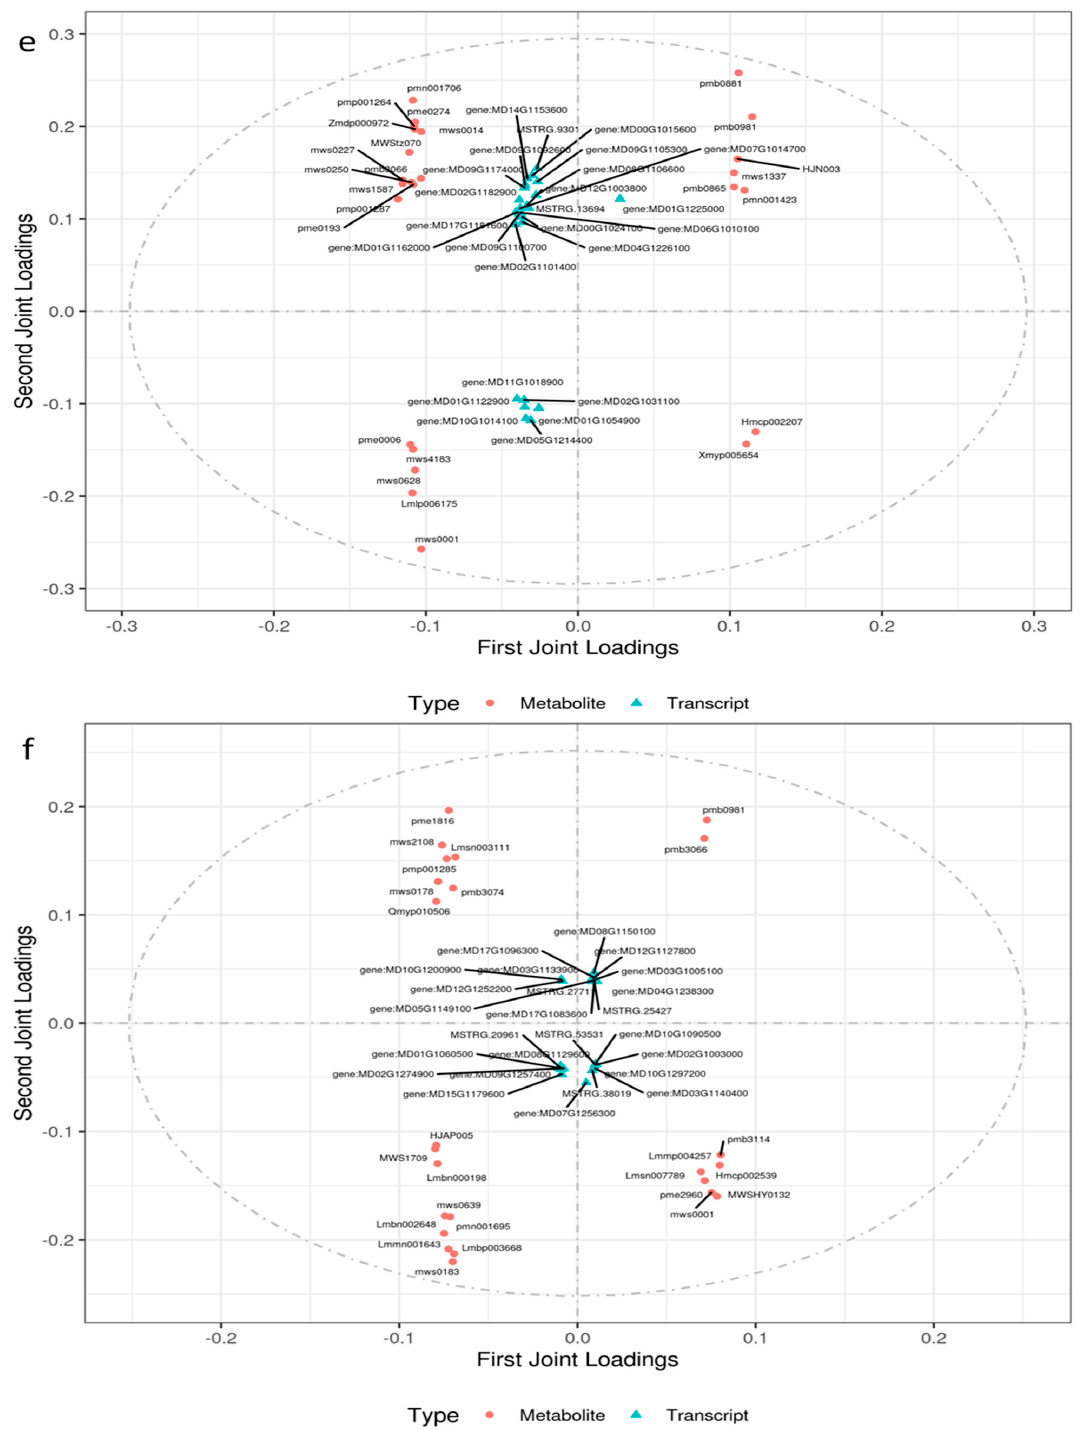
Figure 9. The top 25 joint-loading elements of genes and metabolites in different combinations. ( a ) The top 25 joint-loading elements of genes and metabolites of leaves in M-CKL vs. M-TL. ( b ) The top 25 joint-loading elements of genes and metabolites of leaves in Z-CKL vs. Z-TL. ( c ) The top 25 joint-loading elements of genes and metabolites of leaves in M-TL vs. Z-TL. ( d ) The top 25 joint-loading elements of genes and metabolites of roots in M-CKR vs. M-TR. ( e ) The top 25 joint-loading elements of genes and metabolites of roots in Z-CKR vs. Z-TR. ( f ) The top 25 joint-loading elements of genes and metabolites of roots in M-TR vs.